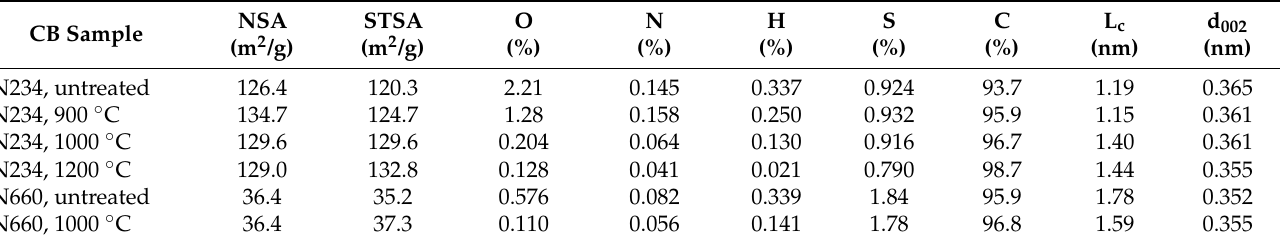
Table 2. Effects of Heat Treatment on CB